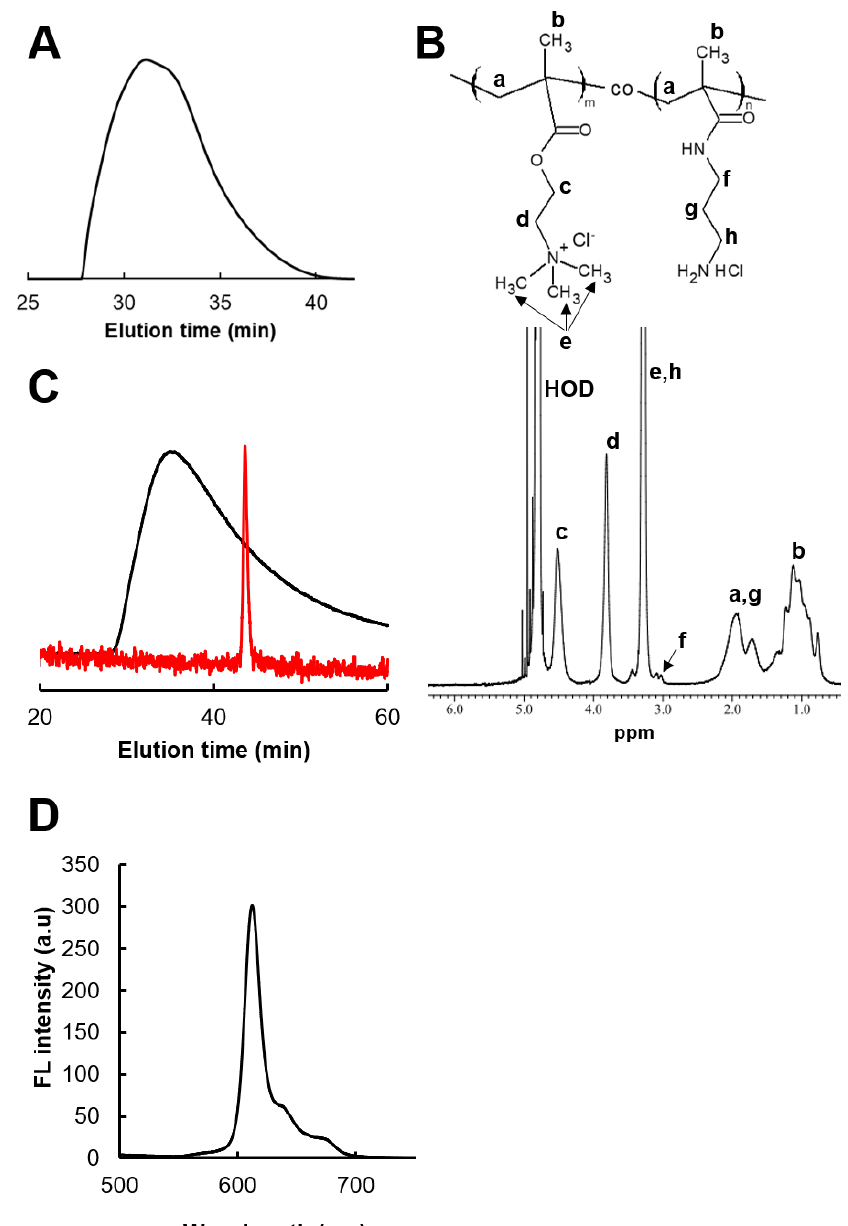
Figure 2. Characterization of PMETAC- co -PAMPAA and PMETAC- co -PAMPAA(HpD). ( A ) SEC chromatogram of PMETAC- co -PAMPAA. ( B ) Chemical structure and 1 H NMR spectrum of PMETAC- co -PAMPAA. The lowercase letters in the chemical structure, which show the proton, correspond to the peak in the 1 H NMR spectrum. ( C ) SEC chromatogram of PMETAC- co -PAMPAA(HpD) (black) and HpD (red), recorded by RF-10A XL fluorescence detector at an excitation/emission of 400/635 nm. ( D ) Fluorescent spectrum of PMETAC- co -PAMPAA(HpD) by the excitation at 375 nm.